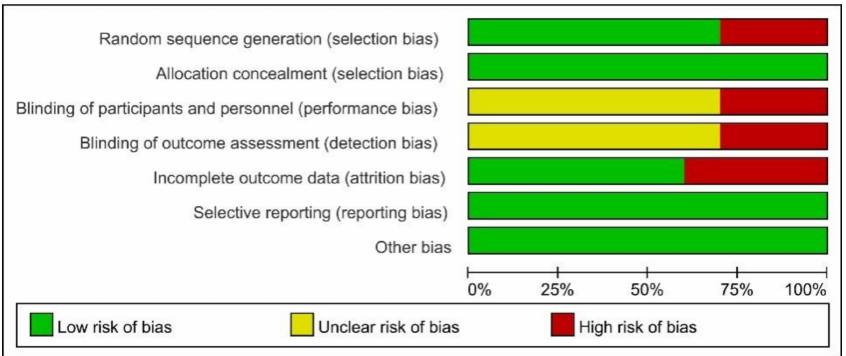
Figure 3. Risk of bias (ROB) results of quality assessment within included studies. Risk of bias levels: low (green), unclear (yellow), and high (red).